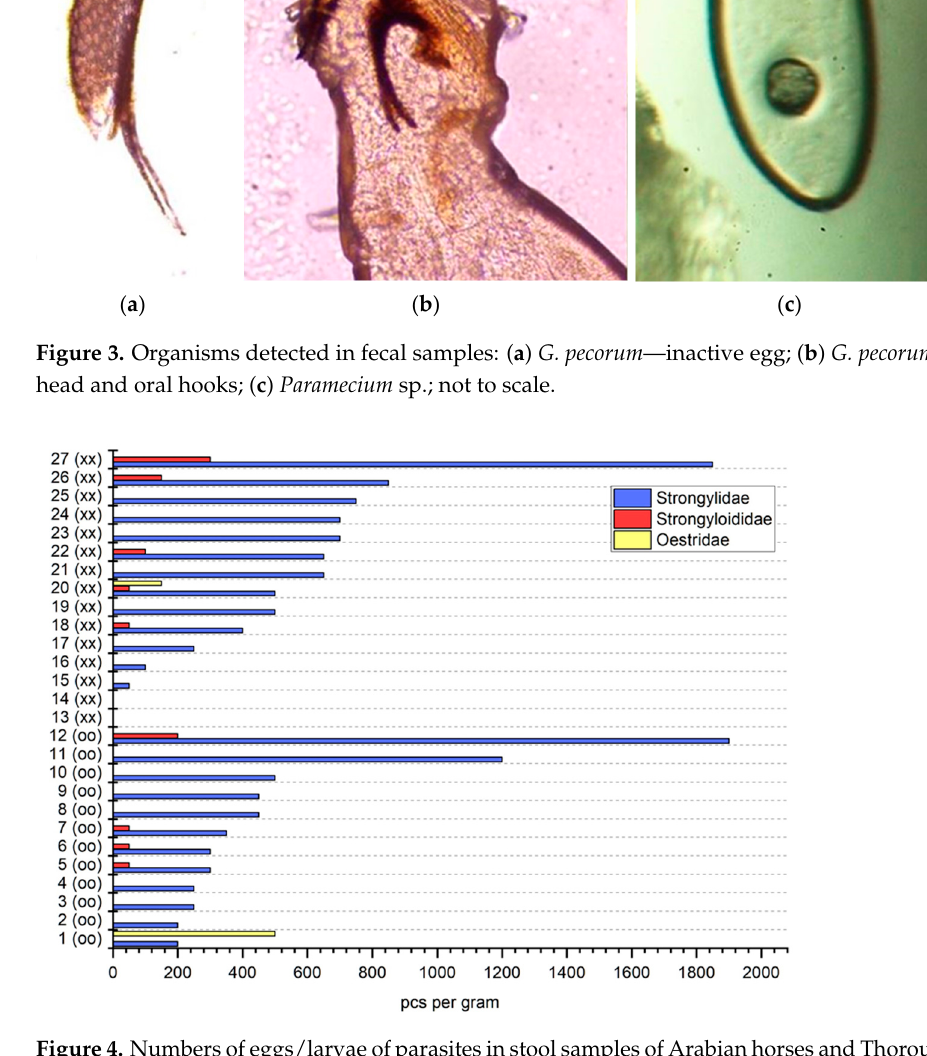
Figure 3. Organisms detected in fecal samples: ( a ) G. pecorum —inactive egg; ( b ) G. pecorum —larval head and oral hooks; ( c ) Paramecium sp.; not to scale.